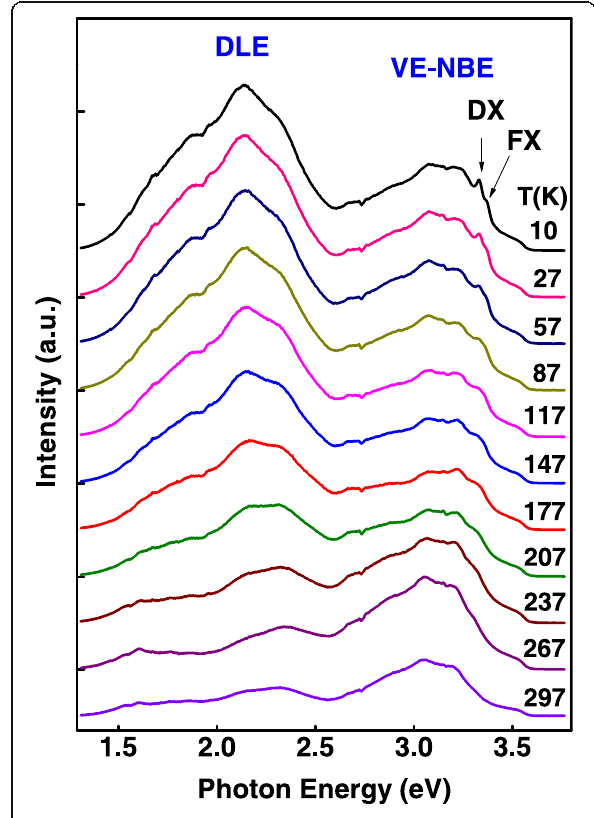
Fig. 7 Temperature-dependent PL spectra of 0.08 M